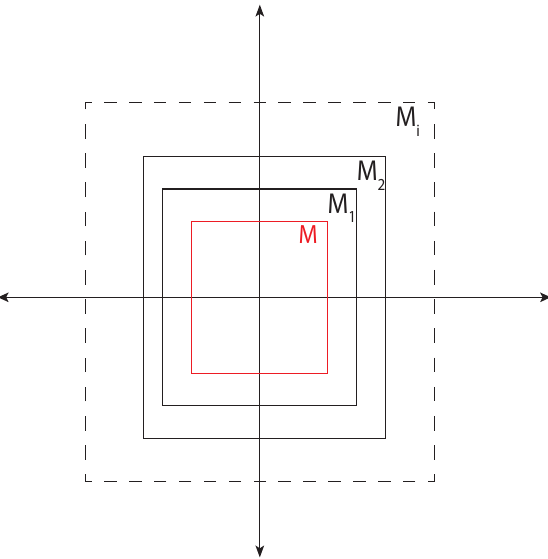
Figure 6. Abstraction of a model contains all reachable states which are reachable by the original model. Here states reachable by all abstraction models M 1 , M 2 , · · · , M i contain reachable states by a vehicle model M